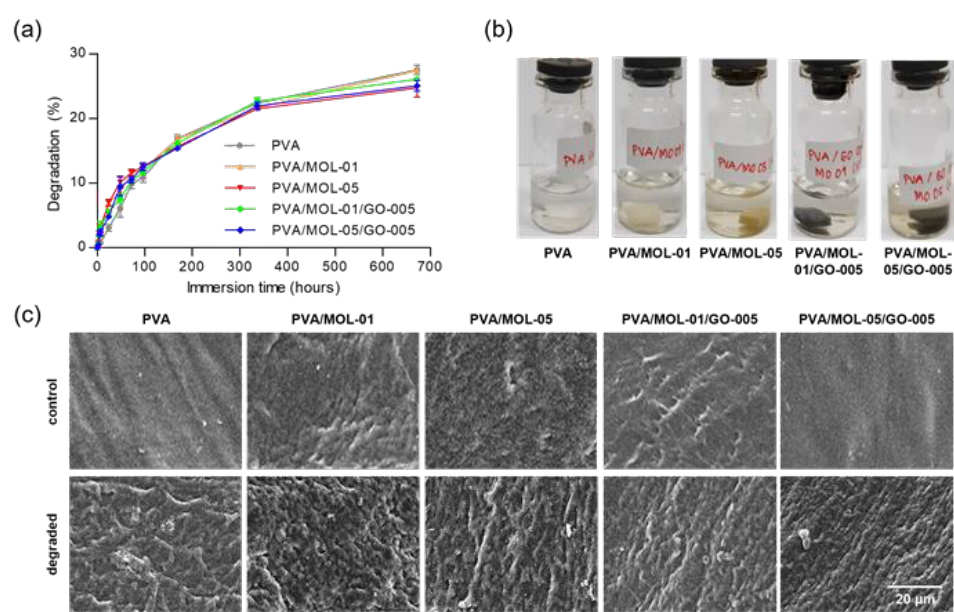
Figure 6. ( a ) Degradation of the hydrogels in PBS. ( b ) Representative images of the liquid in which the degradation test was performed. ( c ) Surface morphology before degradation (control) and after 336 h of immersion in PBS (degraded).